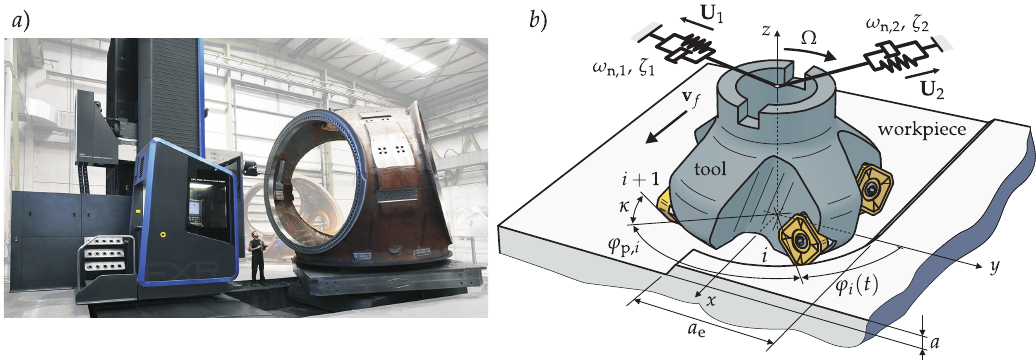
Figure 1. ( a ) Turbine hub machining in a floor-type milling machine with an extensible ram, ( b ) geometry of the considered inserted face milling